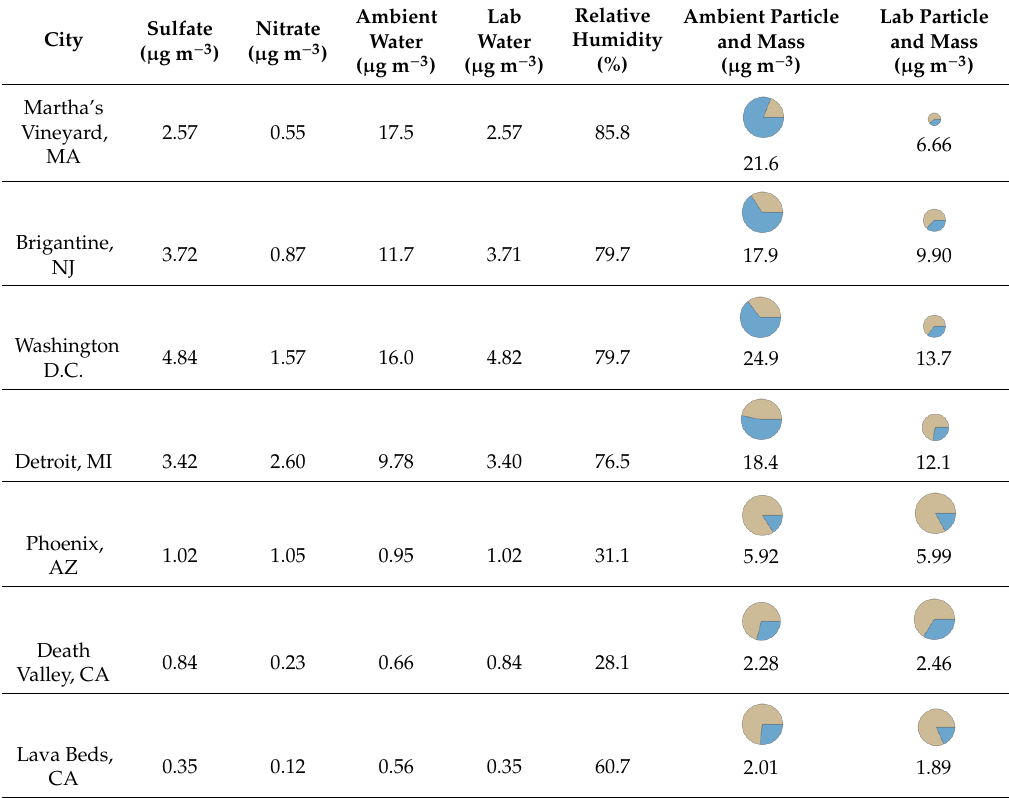
Note: Pie chart colors denote mass fraction of dry material (brown) and water (blue).